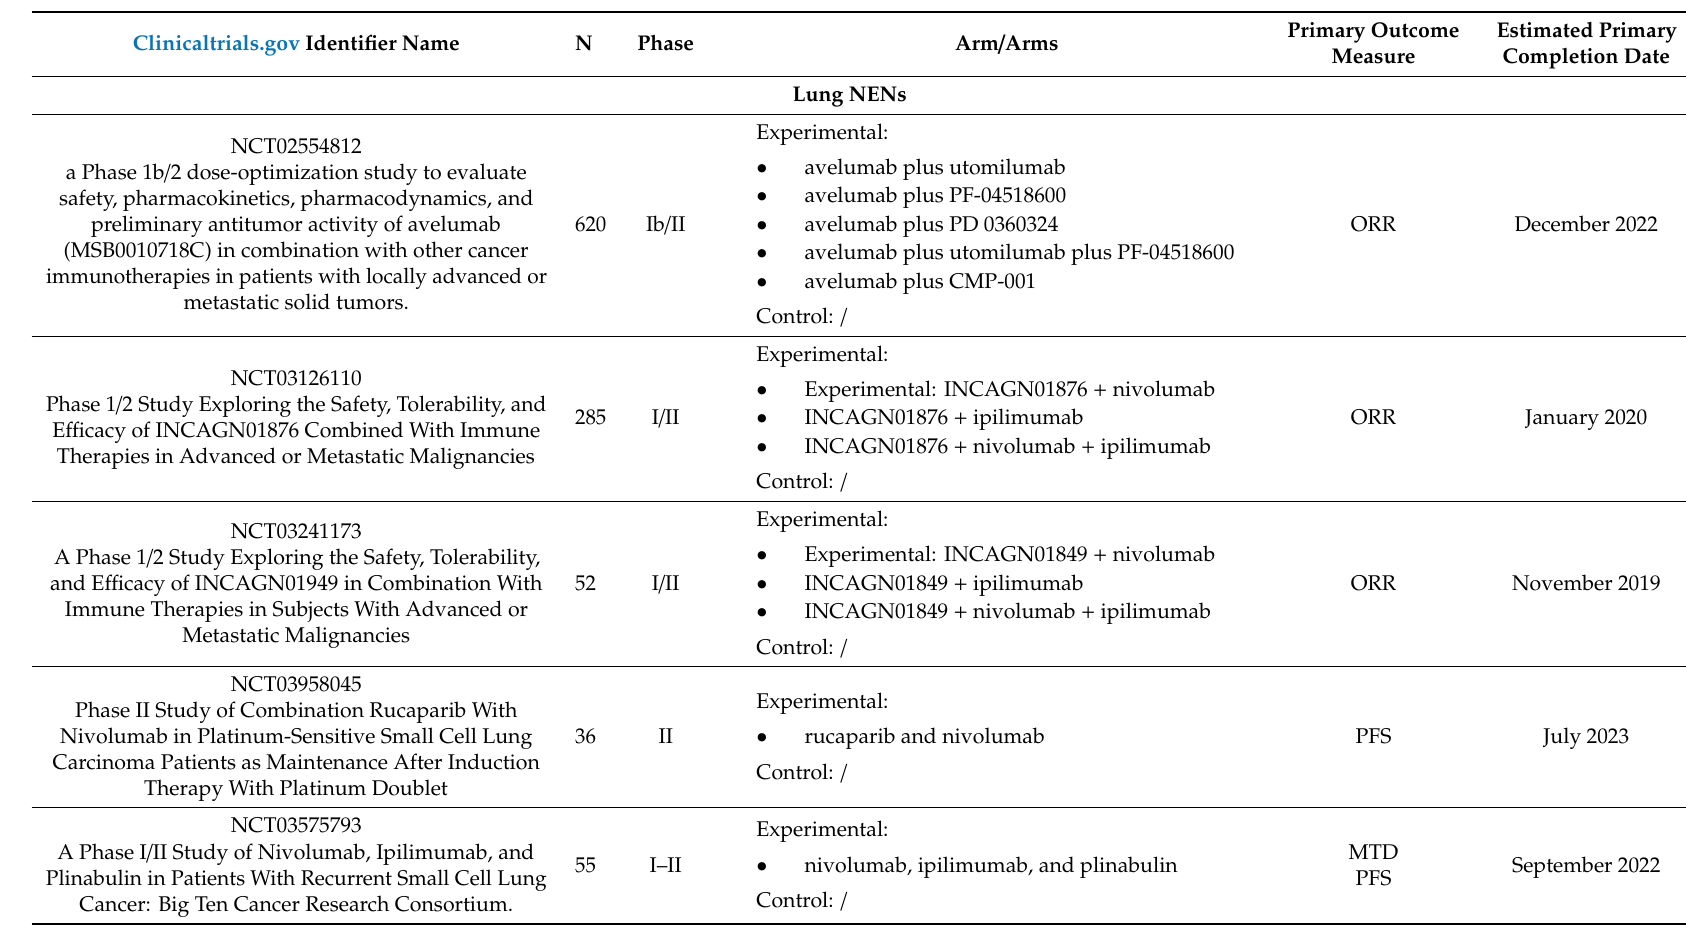
Table 2. Ongoing clinical trials of immunotherapy in NENs discussed in the text (source: clinicaltrials.gov; last accessed: 28 March 2020). Abbreviations: NEN, neuroendocrine neoplasia; N, sample size; PFS, progression-free survival; PFS-12, progression-free survival at 12 months; ORR, objective response rate; DFS, disease-free survival; DFS-12, disease-free survival at 12 months; RFS, relapse-free survival; CBR, clinical benefit rate; MTD, maximum tolerated dose; RP2D, recommended phase 2